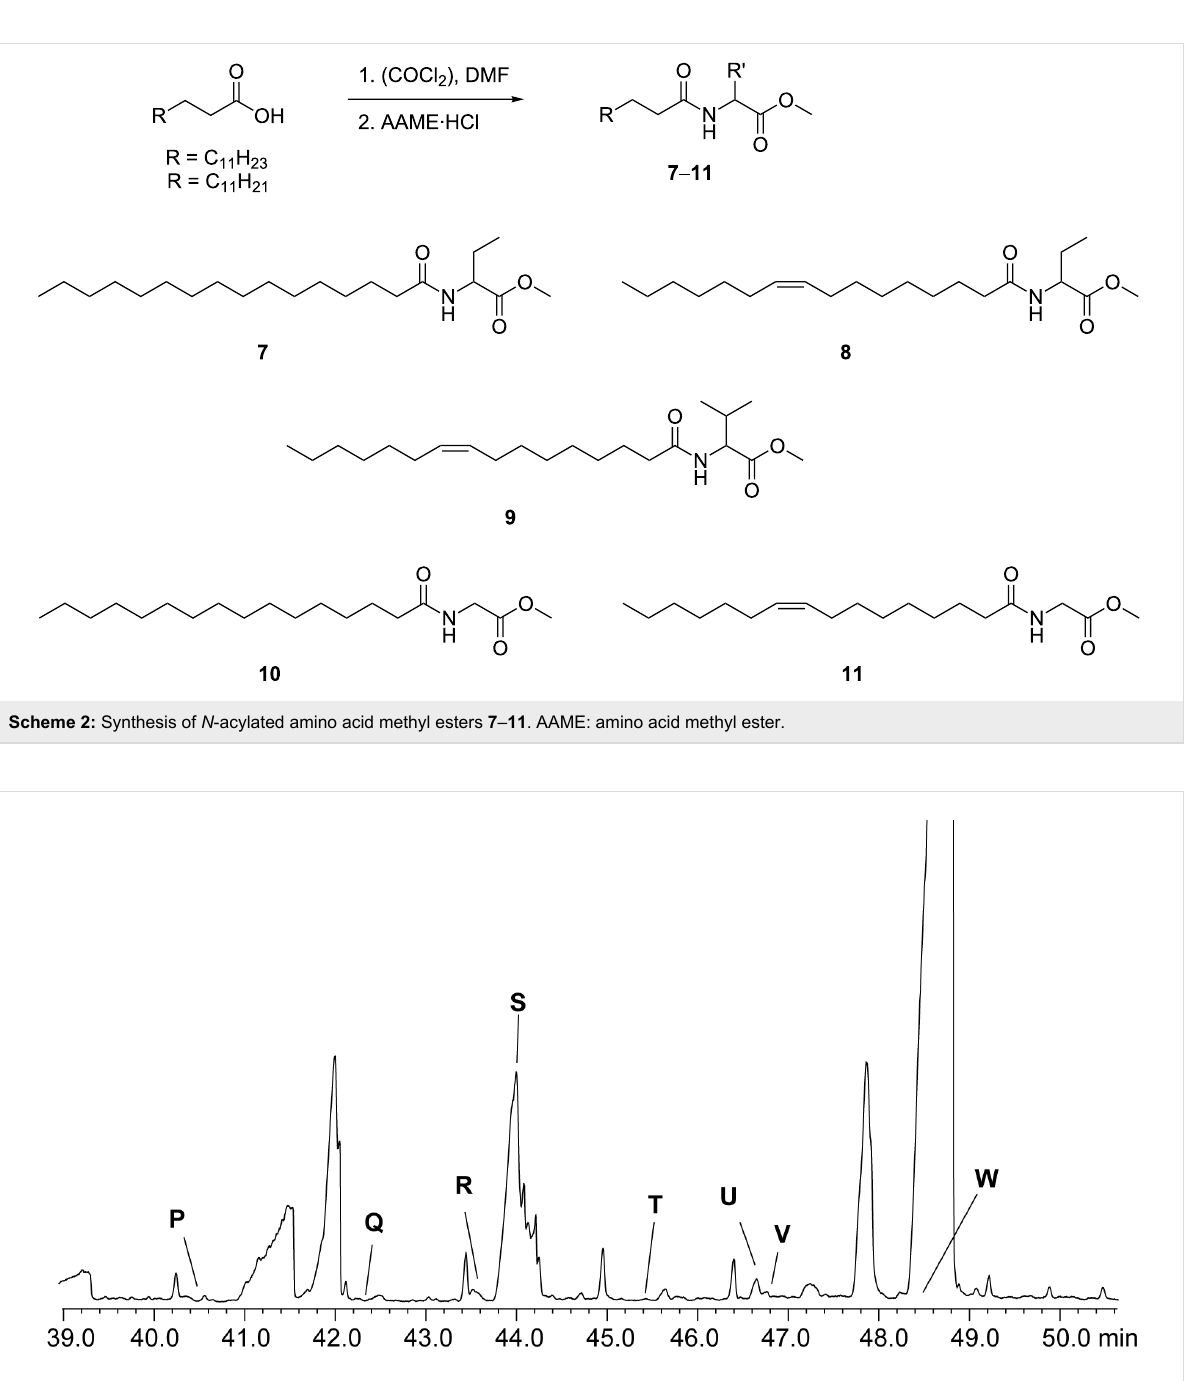
Figure 5: TIC of an XAD extract of Loktanella sp. F14. Compound S is a minor component within the broad peak.